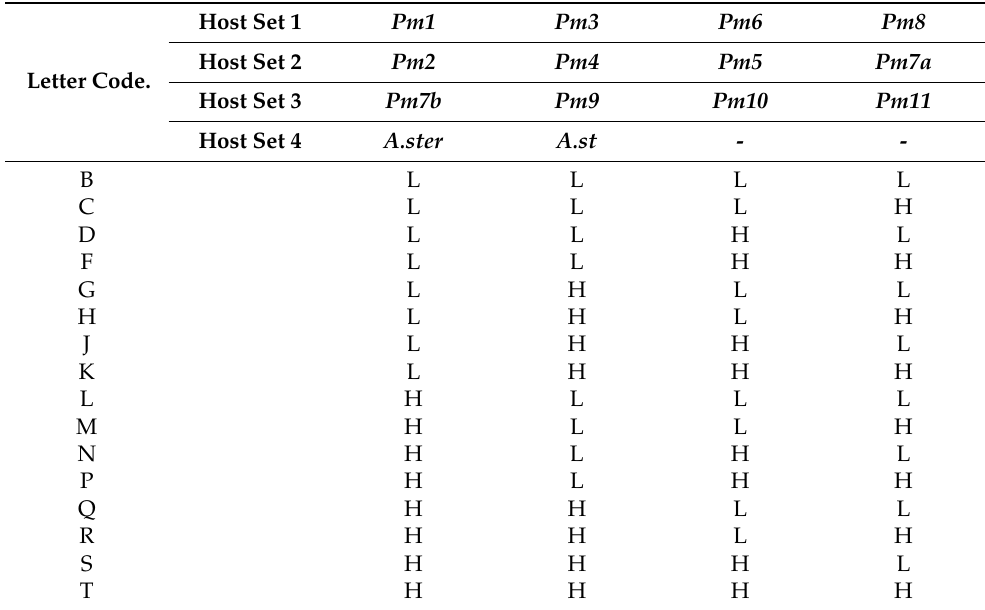
Table 2. Code of 14 differentials for identification of Blumeria graminis f.sp avenae pathotypes.